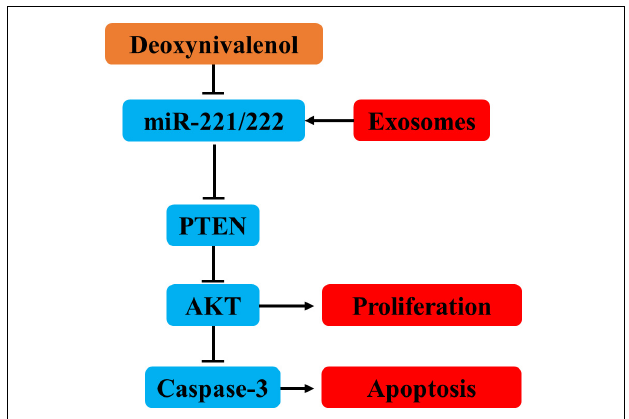
FIGURE 10 | MiR-221/222 ameliorated the Don-induced apoptosis and proliferation inhibition in intestinal epithelial cells by targeting PTEN.